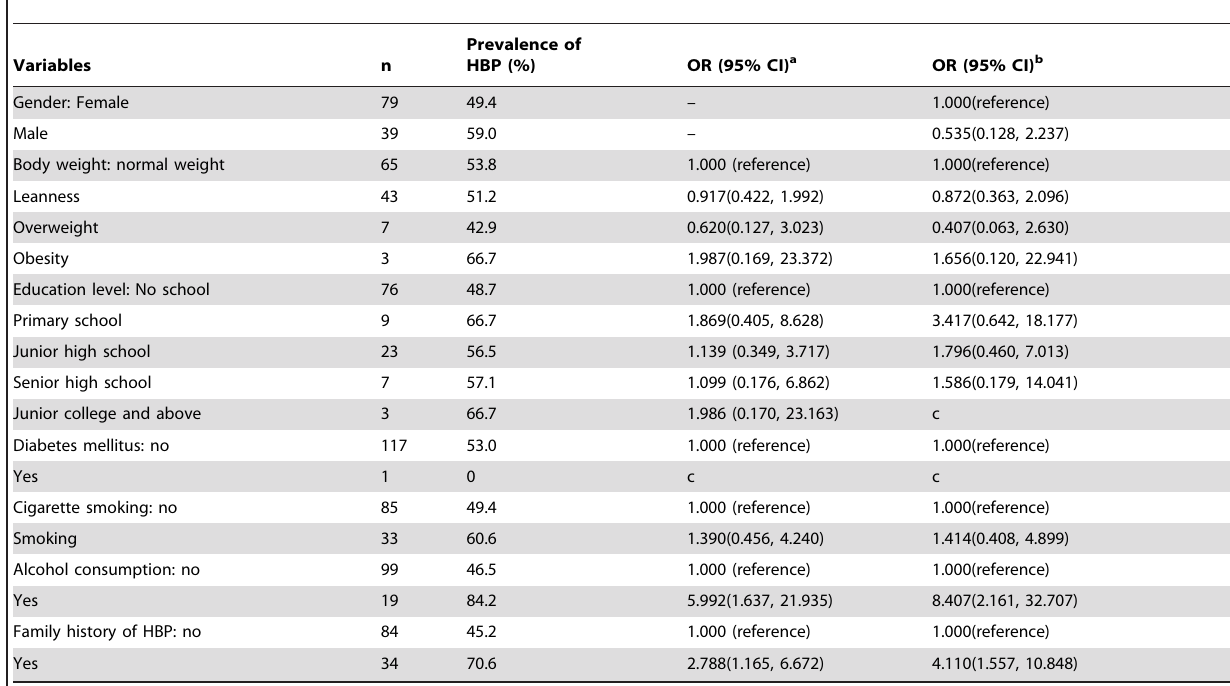
Table 7. Factors associated with the prevalence of hypertension from multivariate logistic regression models in age group 80– (N=